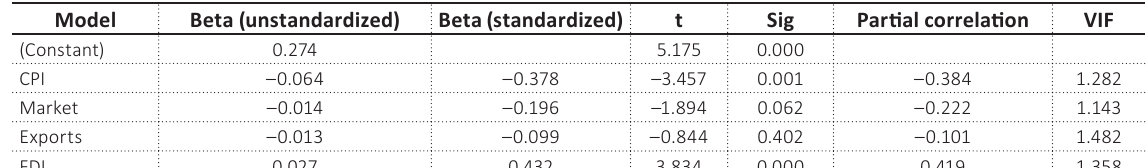
Table 8. Main results for Model